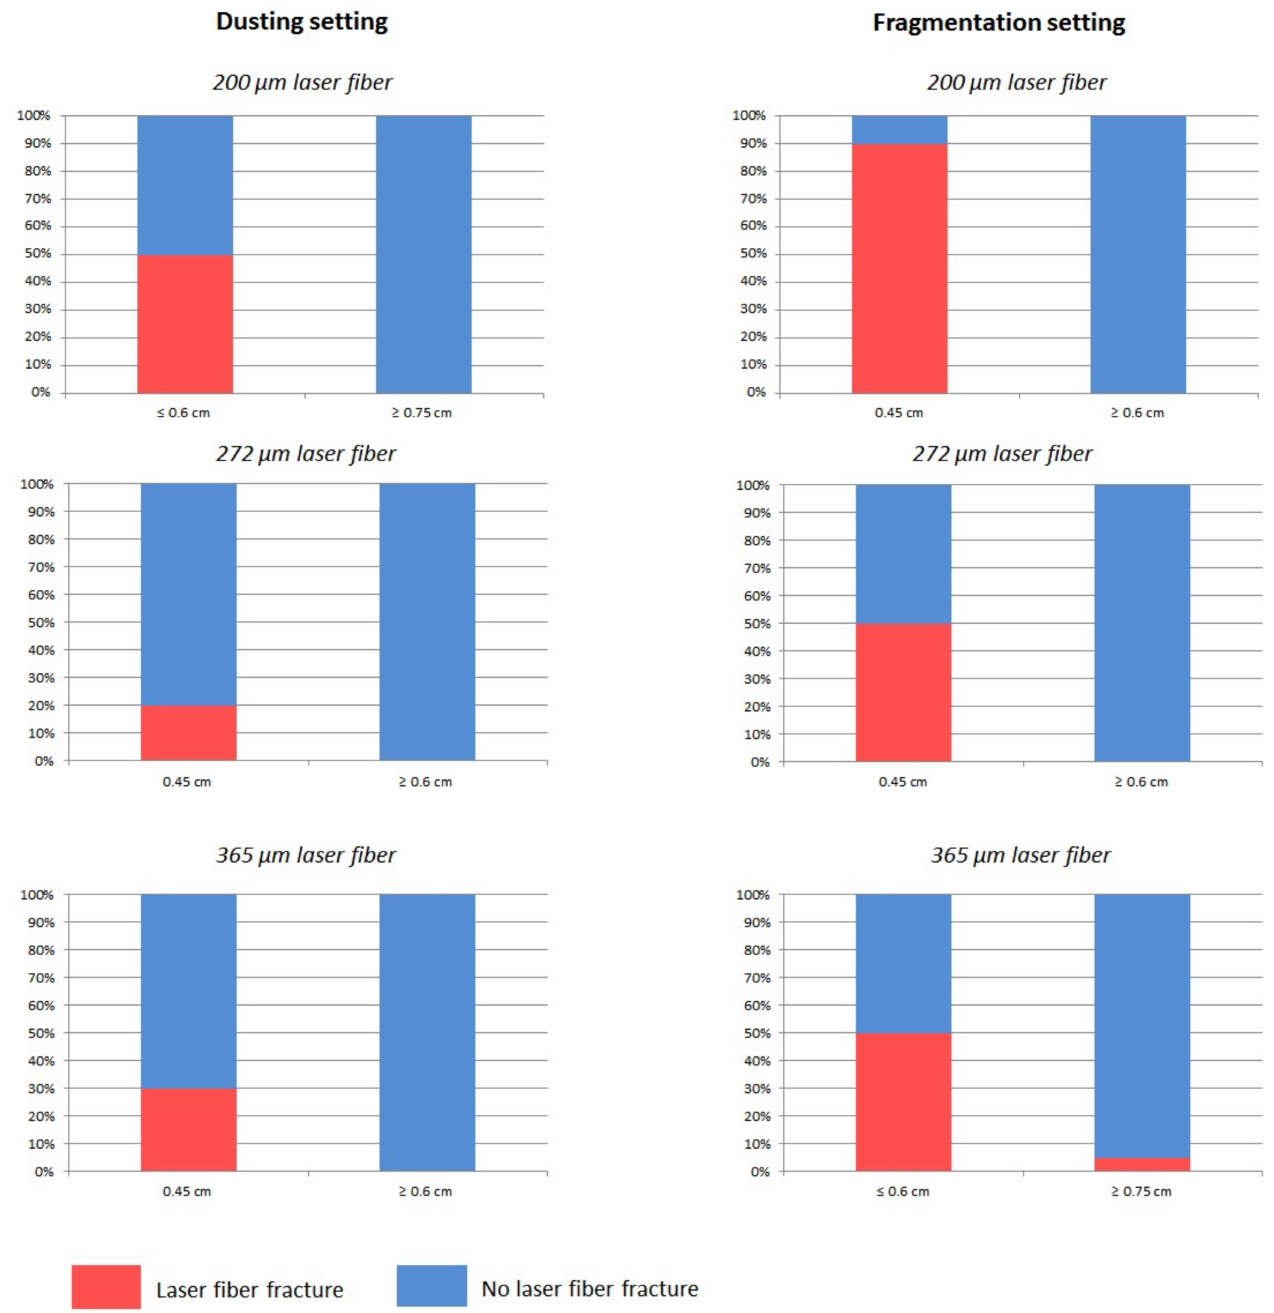
Figure 2. Proportion of fiber failures with Ho:YAG laser according to laser setting, fiber diameter, bending